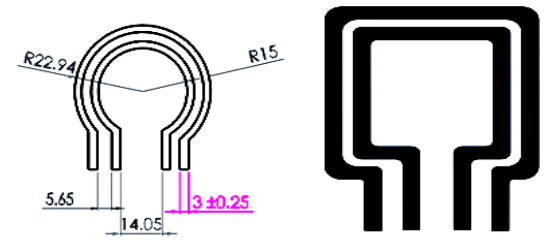
Figure 1. Two different configurations of design of the single-loop coil (SLC) sensor probe: Mild steel (circular shape) and brass (rectangular shape) .